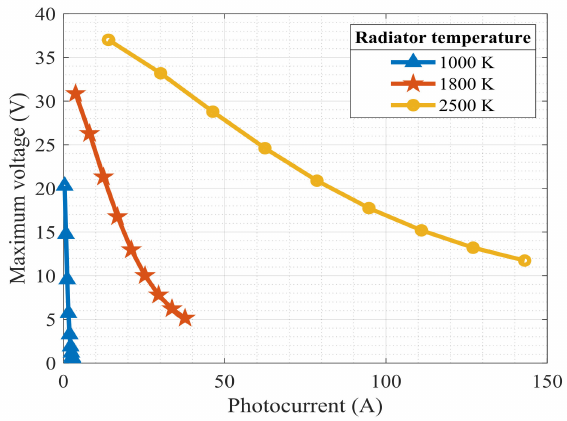
Figure 8. Relationship between photocurrent and maximum voltage of the TPV system when the temperature of the radiator at 1000, 1800, and 2500 K while the PV cells vary from 300 to 700